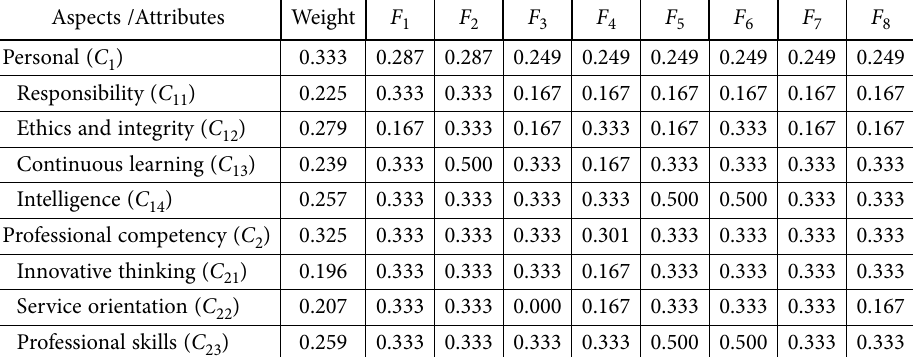
Table 10. Aspiration gaps and ranking for eight personnel in the PROMETHEE-AS method Aspects